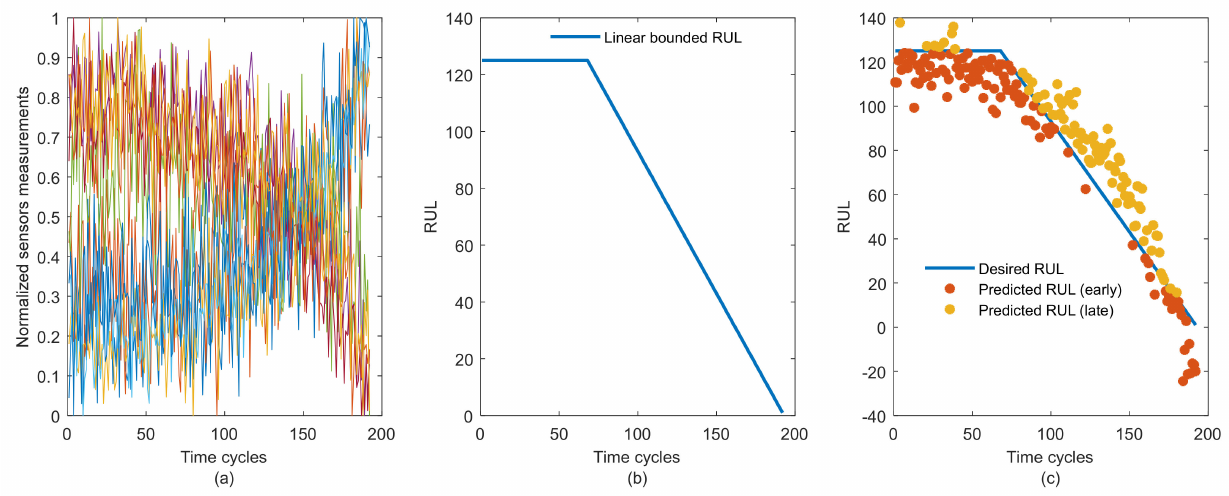
Figure 4. Illustration of data behavior in a single life cycle (i.e., cycle1 from FD001) from C-MAPSS dataset: ( a ) Run-to-failure sensors measurement during gradual degradation; ( b ) Defined RUL targets for life cycle; ( c ) Early and late RUL predictions resulted from the target curve fitting with a linear